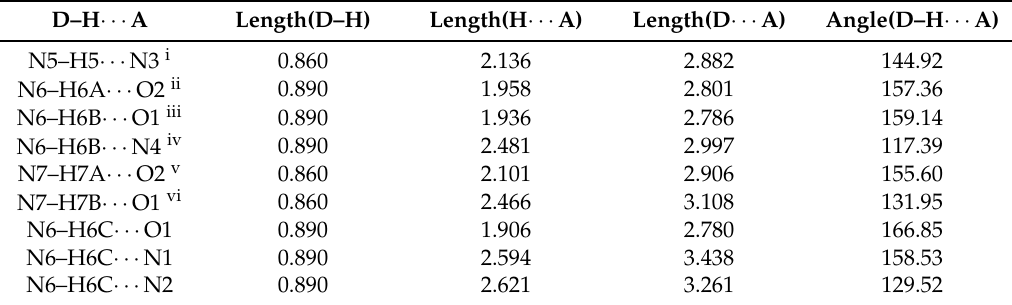
Table 3. Hydrogen bond lengths/Å and bond angles/° for salt 2(SCZ) ∙ BTO.